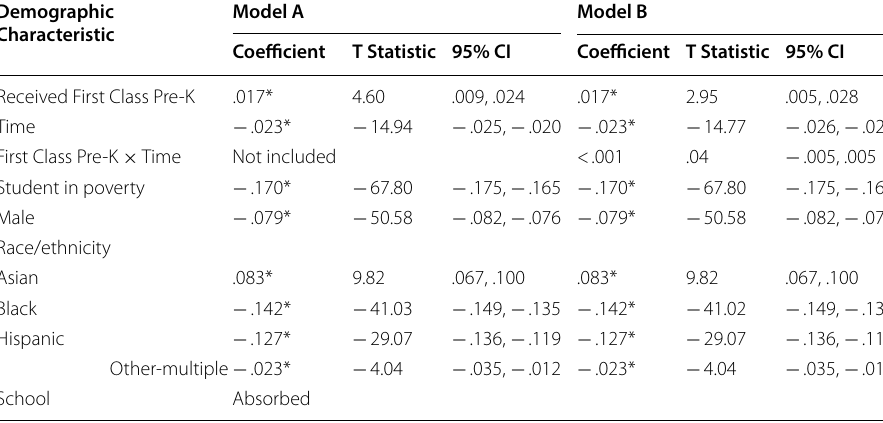
Table 4 Reading proficiency (scored level 3 or level 4 of ACT Aspire and Never Retained); 3rd–7th grades; 2014/2015, 2015/2016, 2016/2017 school years ( n observations)